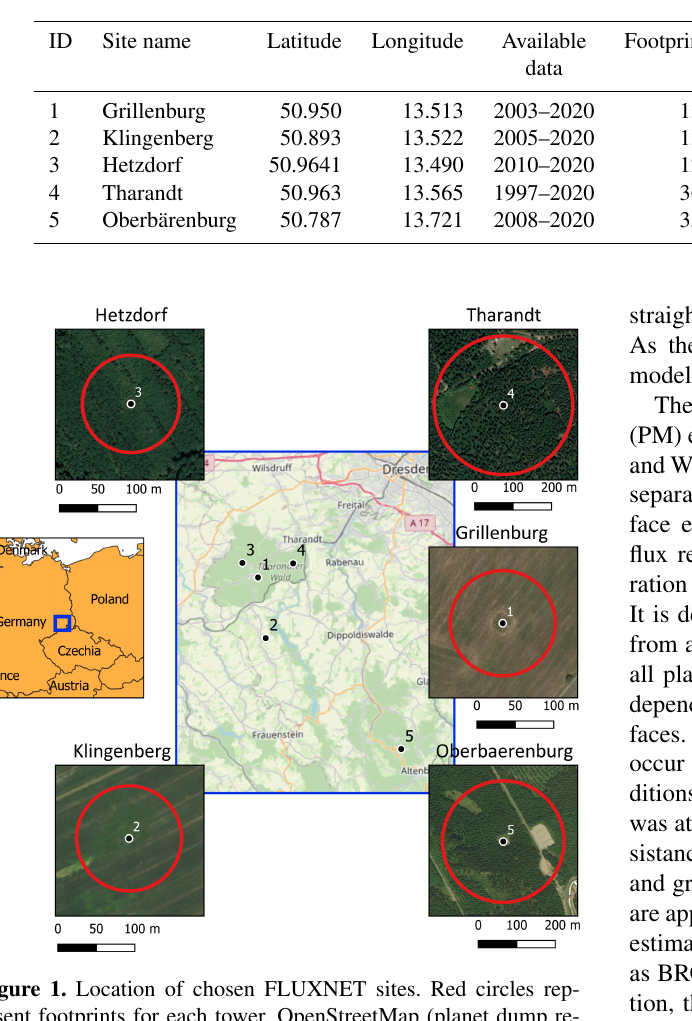
Table 1. Short summary on the chosen FLUXNET sites.